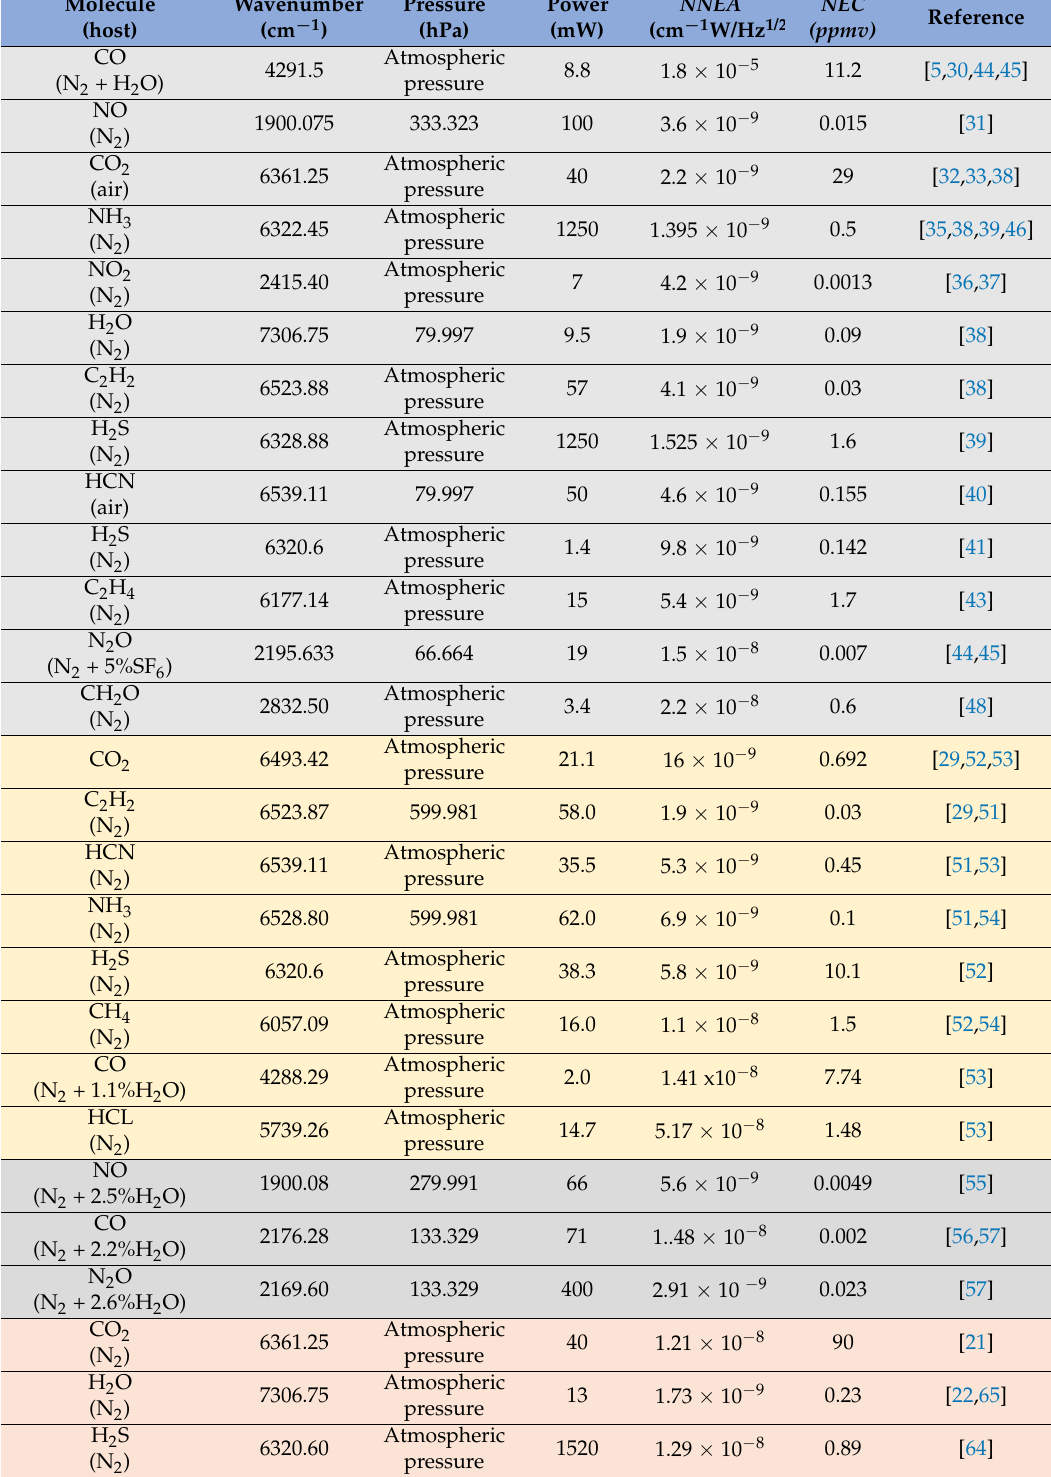
Table 3. Four different ADMs-based QEPAS performance for 15 trace gas species. NNEA: normalized noise equivalent absorption coefficient, NEC: normalized noise equivalent